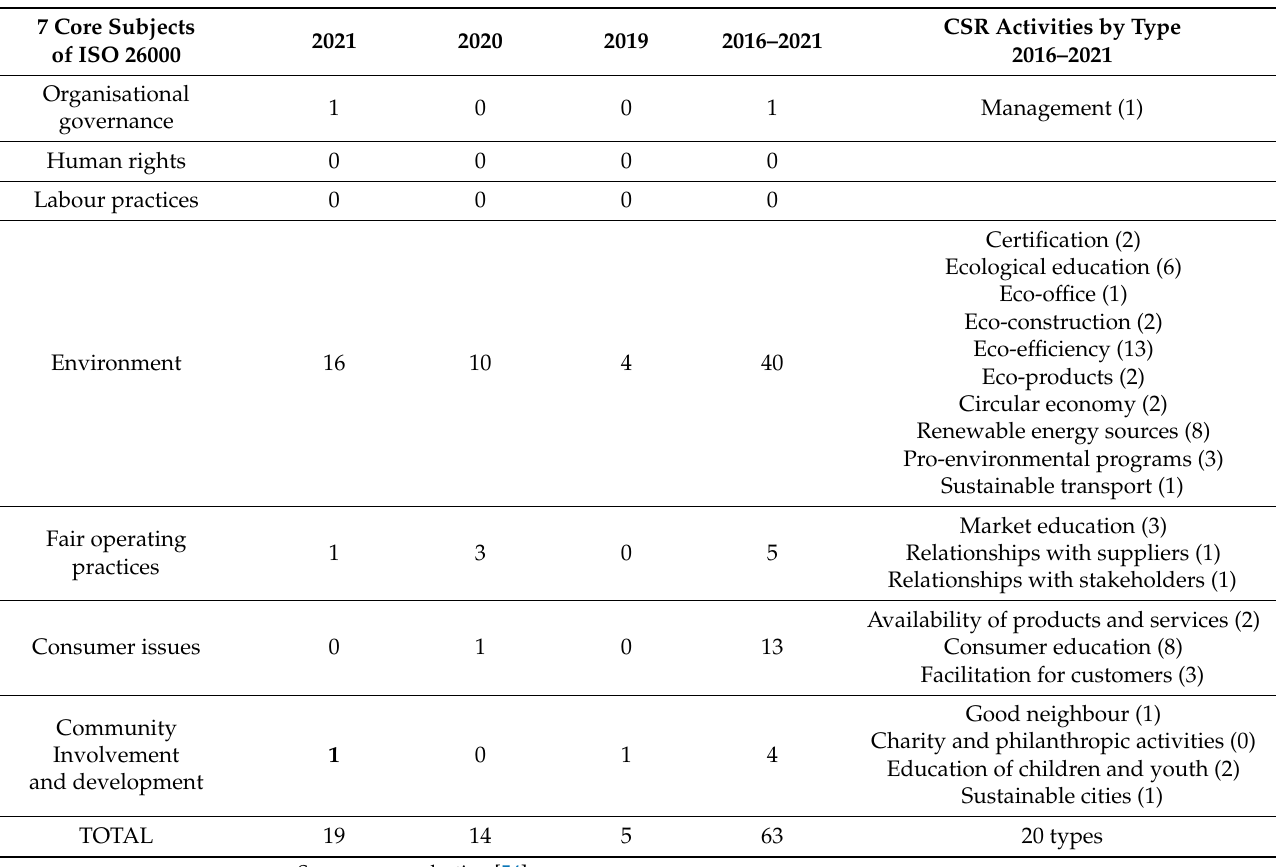
Table 1. CSR good practices in the energy sector in Poland in a framework SDG 7 by core subjects of ISO 26000 (in